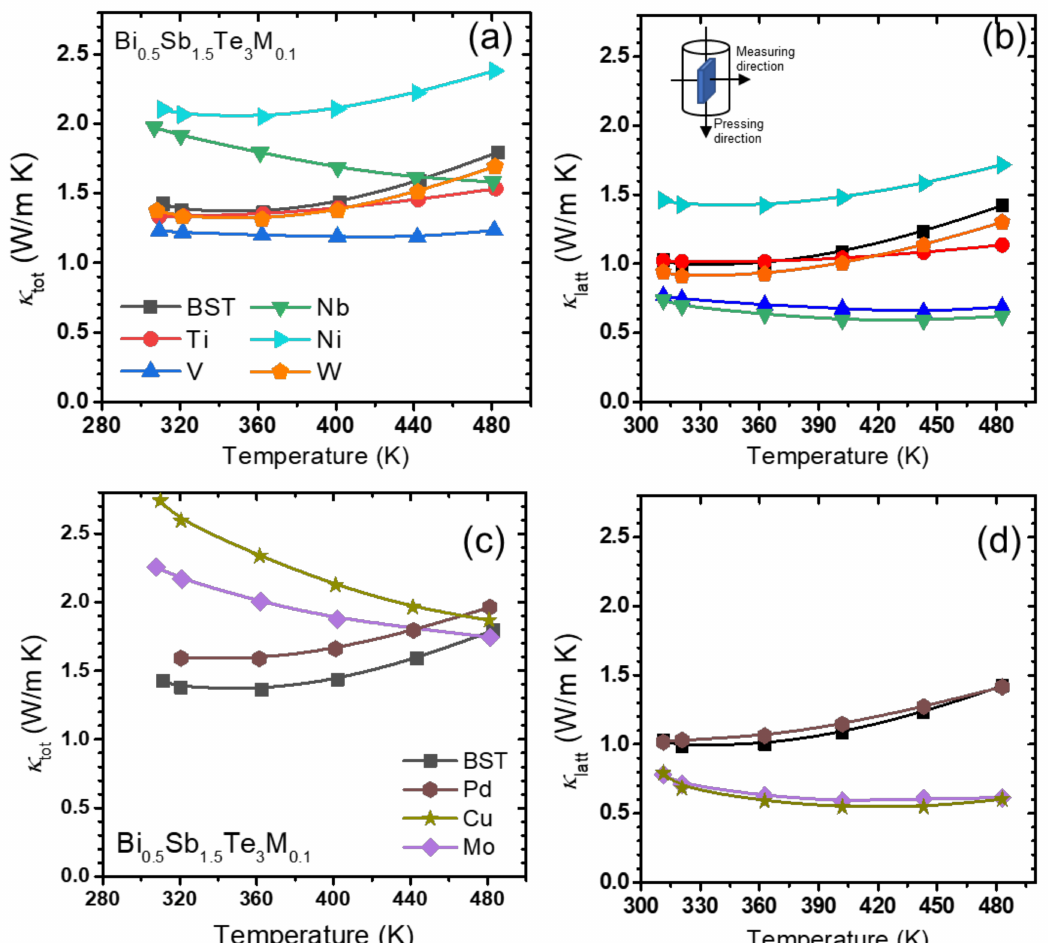
Figure 6. ( a ) κ to t and ( b ) κ latt as a function of temperature for Bi 0.5 Sb 1.5 Te 3 M 0.1 ( M = Ti, V, Nb, Ni and W); ( c ) κ tot and ( d ) κ latt as a function of temperature for Bi 0.5 Sb 1.5 Te 3 M 0.1 ( M = Ni, Pd and